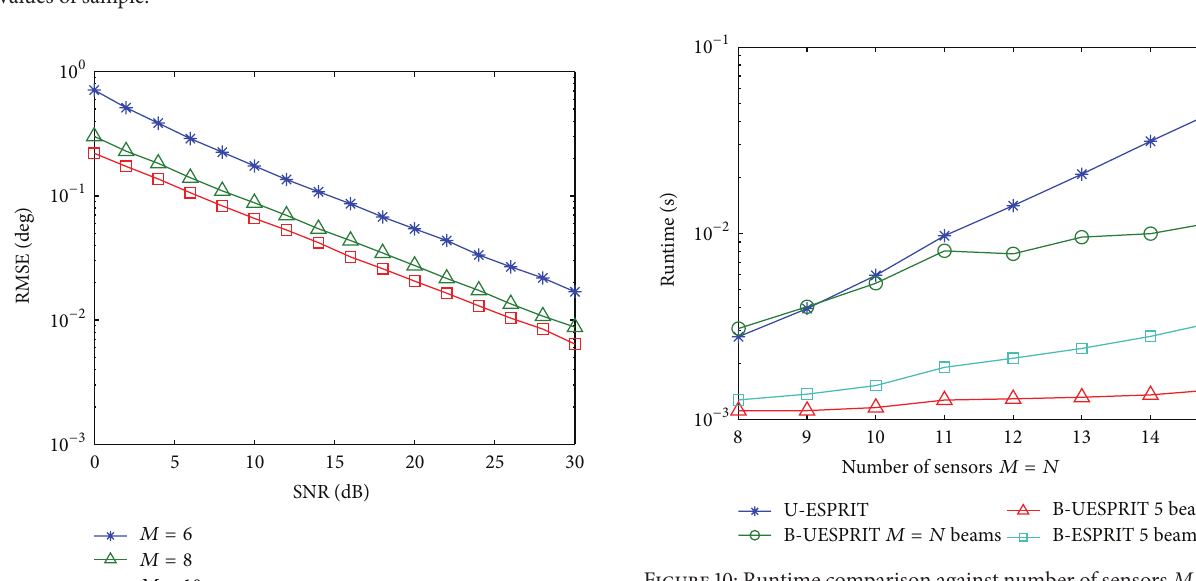
Figure 10: Runtime comparison against number of sensors 𝑀 = 𝑁